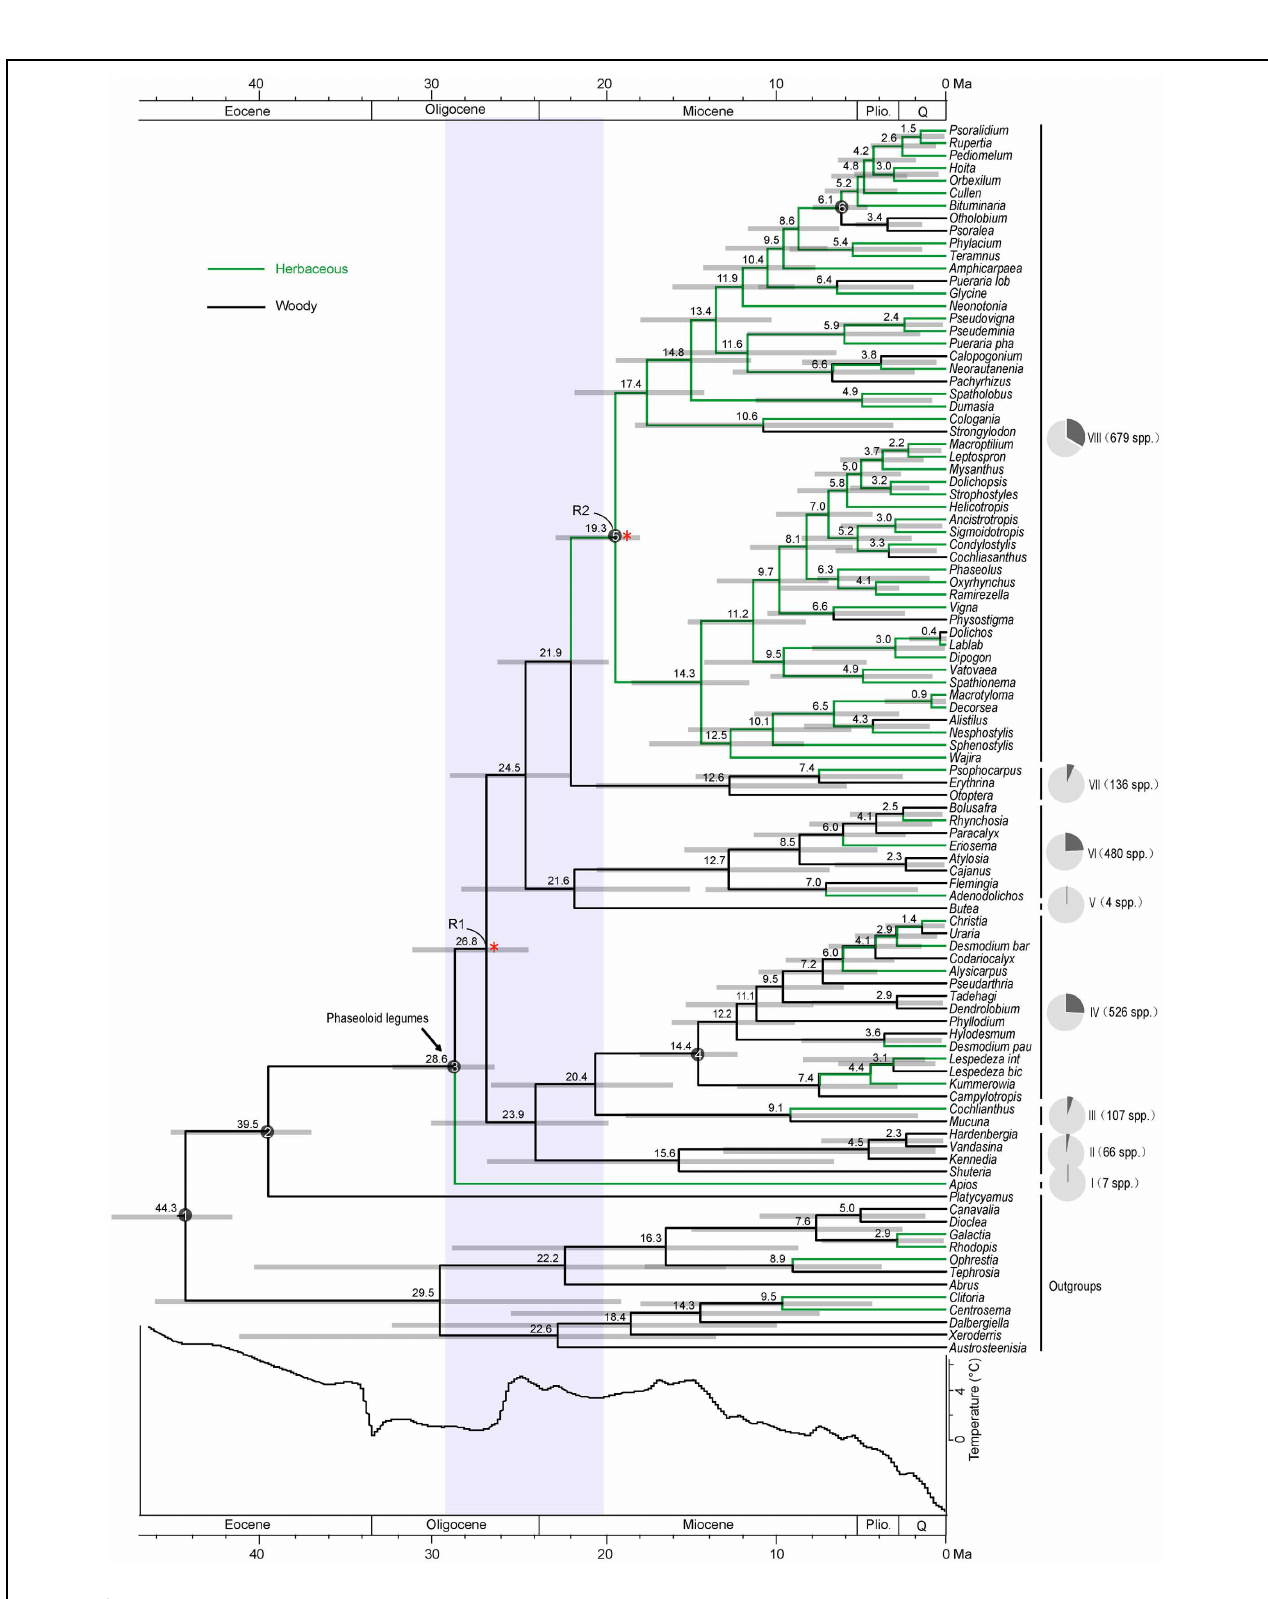
FIGURE 1 | Combined chronogram and habit shift analysis of the phaseoloid legumes. Numbers above branches are divergence times estimated using BEAST. Gray bars show 95% credibility interval. White numbered nodes represents the calibration node. Red asterisks indicate the